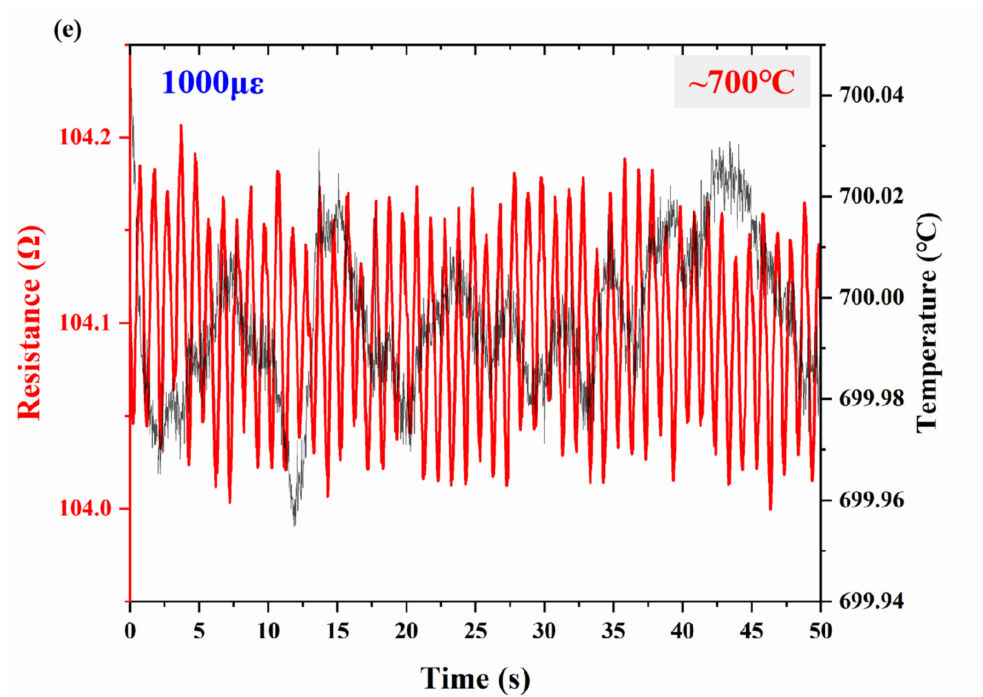
Figure 8. Strain response of Pt TFSGs: ( a ) 400 ◦ C, 5 cycles; ( b ) 500 ◦ C, 5 cycles; ( c ) 600 ◦ C, 5 cycles;